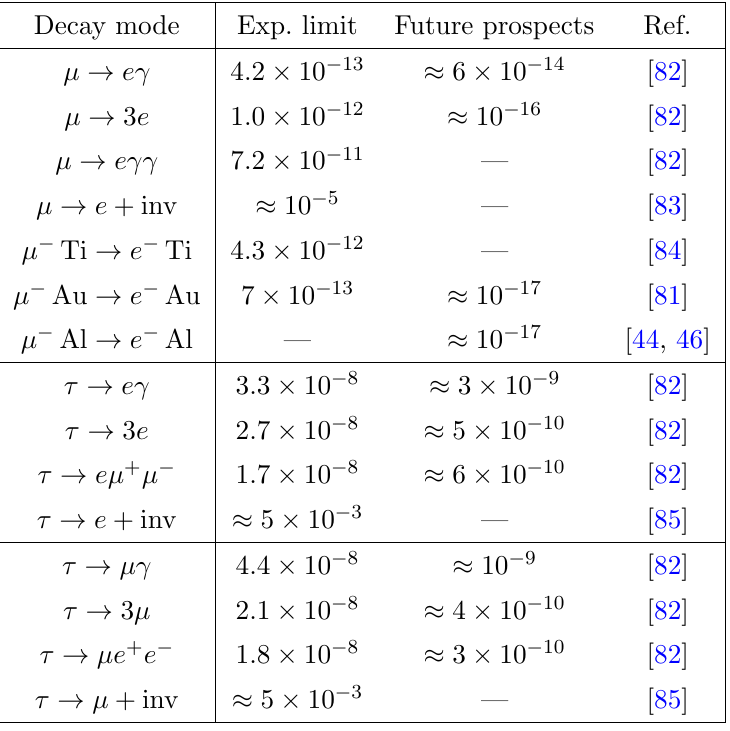
Table 1 . Most relevant experimental limits on purely leptonic LFV processes and future prospects for MEG-II [86], Mu2E [44], Mu3E [45], COMET [46] and Belle-II [43]. which behaves as B ( (cid:28) ) 1 = p (cid:28) in the (cid:28) asymptotic limit, in such a way that 1 (cid:25) ! 1 only fermions lighter than m contribute signi(cid:12)cantly to eq. (3.36). To derive the relevant a constraints to this scenario, it is crucial to determine the ALP total width, (cid:0)